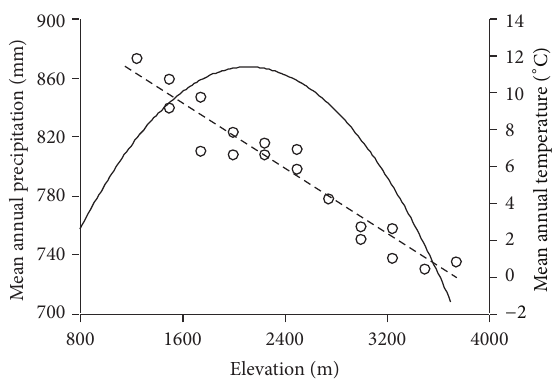
Figure 3: Relationships between elevation and mean annual tem- perature (MAT) (dash line) and mean annual precipitation (MAP) (solid